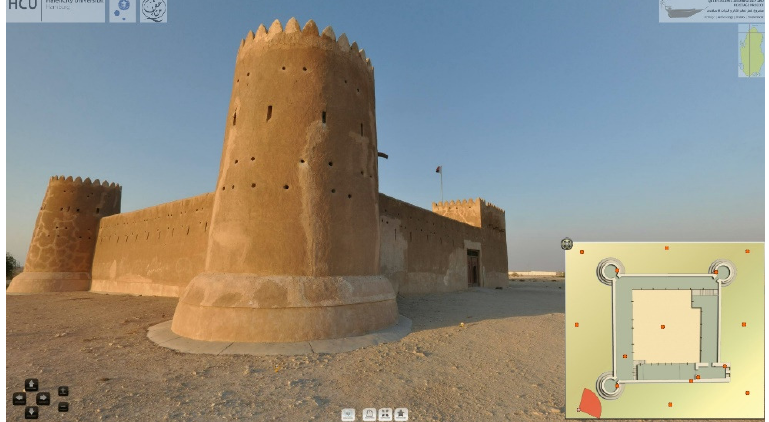
Figure 6: Virtual tour of Al Zubarah fortress using a set of 16 full-spherical panorama images